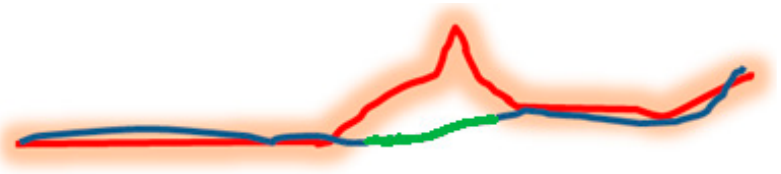
Figure 5. The red line represents the reference river bank line, and the orange area is its buffer area. Part of the extracted river boundary (blue) is in accordance with the reference, whereas the green part is an inaccurate boundary. The boundary index (BI) refers to the ratio between the lengths of the blue and red lines.